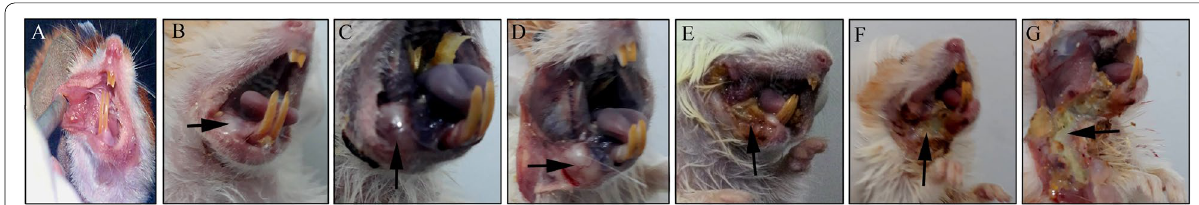
Fig. 1 A plate of clinical pictures during treatment with DMBA and genistein. The HBP showing A no clinical changes, group 1; B areas of white patches at 4 weeks, group 2; C moderate exophytic nodule at 15 weeks, group 2A; D exophytic mass at 18 weeks, group 2A; E ulcerative lesion at 21 weeks, group 2A; F endophytic ulcers with necrotic floor at 24 weeks, group 2A; G massive areas of necrosis and extensive tissue destruction at 24 weeks, group